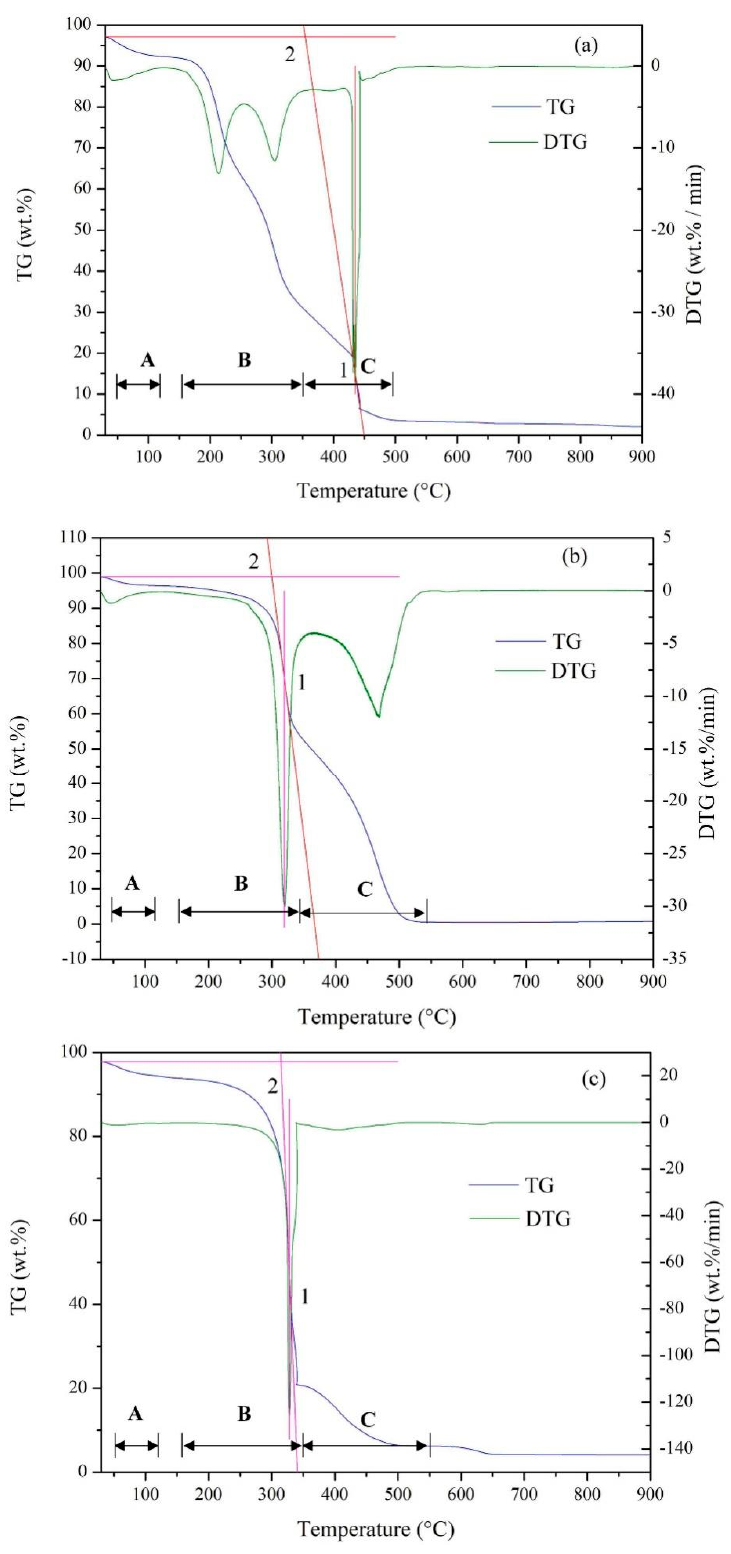
Figure 7. TG-DTG curves of PP and its derived HC products under air conditions. ( a ) PP, ( b ) HC-210, and ( c ) HC-190-CaO.